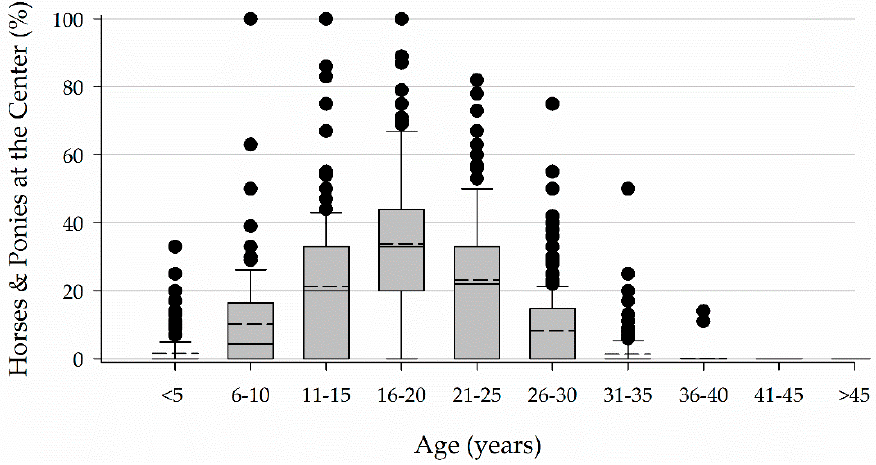
Figure 5. Age of horses and ponies. Horses and ponies spent anywhere from less than a year to over 20 years in a program. Respondents reported the greatest percentage (28, 0–73.75) of horses and ponies in their programs stayed active for 1 to 6 years (Figure 6).